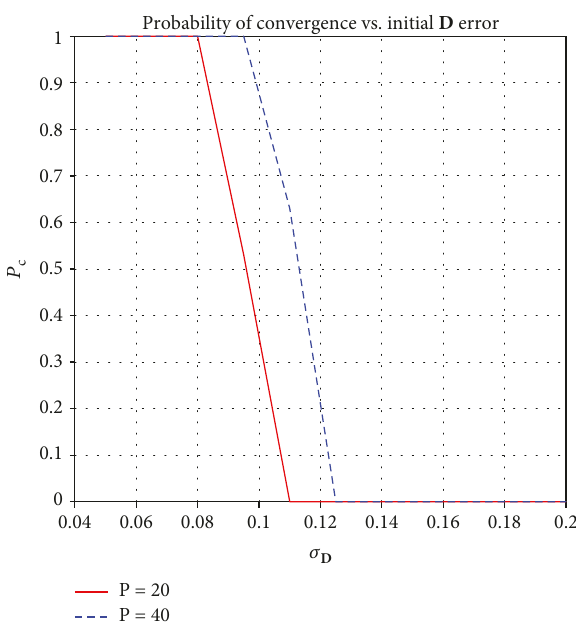
Figure 7: The probability of convergence as a function of the initial D mismatch 𝜎 , for 𝑃 = 20 and 𝑃 = 40 D